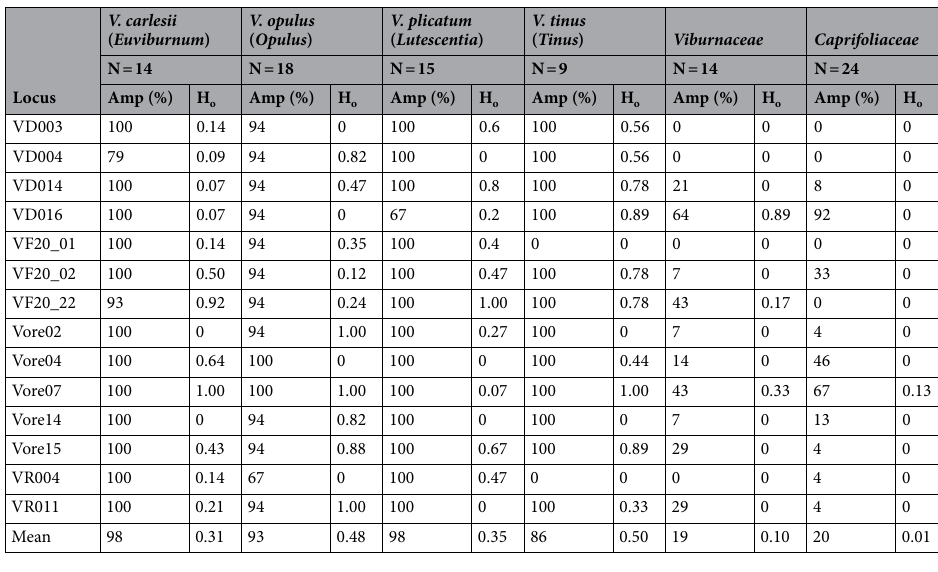
Table 2. Comprehensive 14 SSR marker set amplification percentages and observed heterozygosity in Viburnum carlesii ( Euviburnum subclade), V. opulus ( Opulus subclade) , V. plicatum ( Lutescentia subclade), and V. tinus ( Tinus subclade). N number of individuals sampled; Amp percent amplification within the expected base pair size; Ho Observed